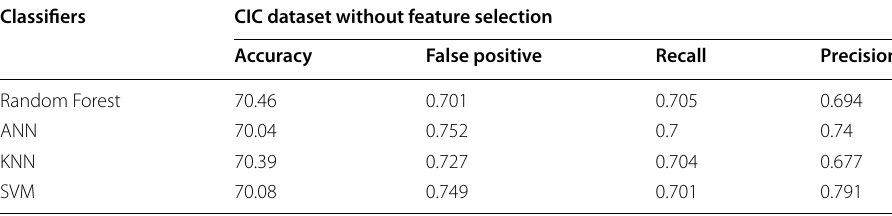
Table 17 Results on CICIDS without any feature selection